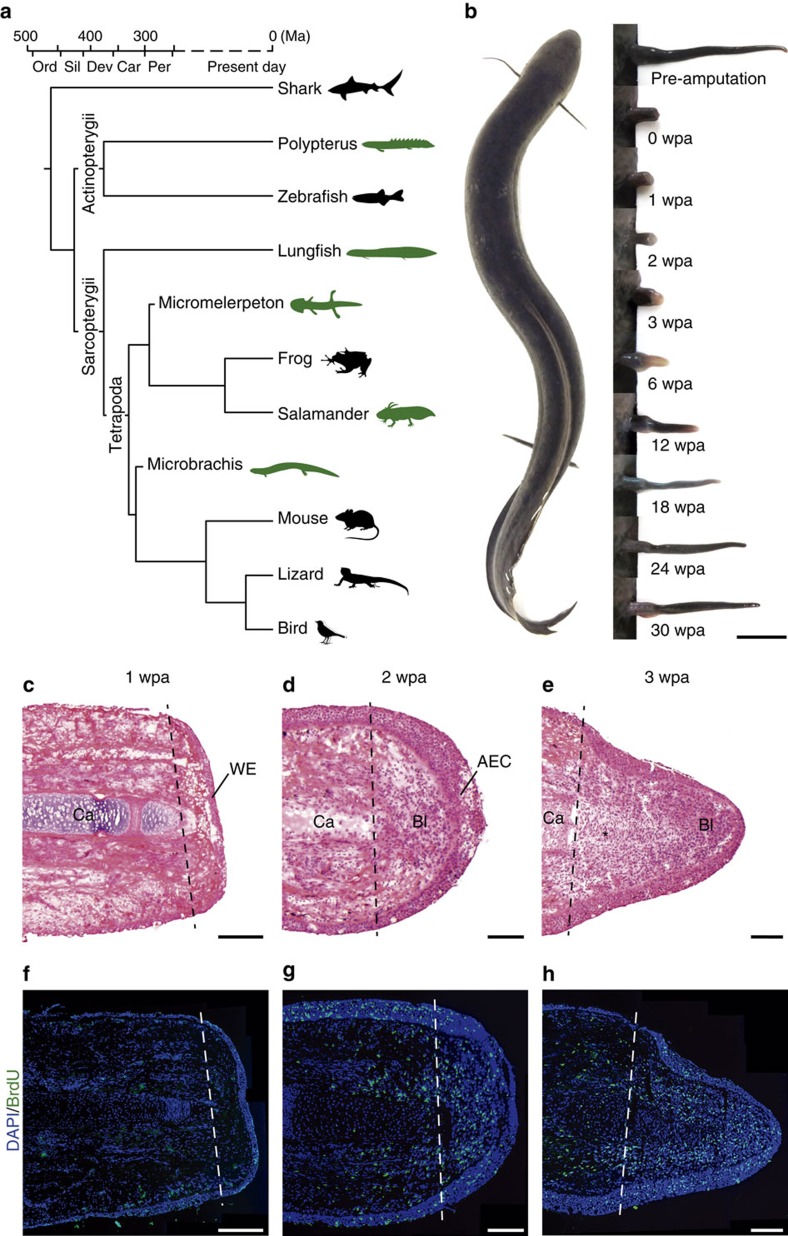
Fin regeneration and blastema formation in the L. paradoxa.(a) Vertebrate phylogenetic tree, highlighting in green extant and extinct taxonomic groups capable of complete appendage regeneration among actinopterygians (Polypterus), sarcopterygian fish (lungfish) and tetrapods (salamanders, Micromelerpeton and Microbrachis). (b) Pectoral fin regeneration monitored for 30 wpa in an adult L. paradoxa specimen. (c,f) At 1 wpa, formation of a WE occurs with minimal mitosis. (d,g) At 2 wpa, AEC forms and cells accumulate distally and form a blastema, cell proliferation occurs in regions flanking the cartilage and in the blastema. (e,h) At 3 wpa, blastema extends distally, new cartilage is forming and cell proliferation intensifies. Haematoxylin and eosin stained sections are shown (c–e). Proliferating cells during fin regeneration are shown (green), the nuclei of all cells is stained (blue) (f–h). Dashed lines denote amputation planes. Asterisk denotes newly formed cartilage. Scale bars of 10 mm (b), 1 mm (c,f) and 0.5 mm (d,e,g,h). Ca, cartilage; Bl, blastema; Ma, million years ago.